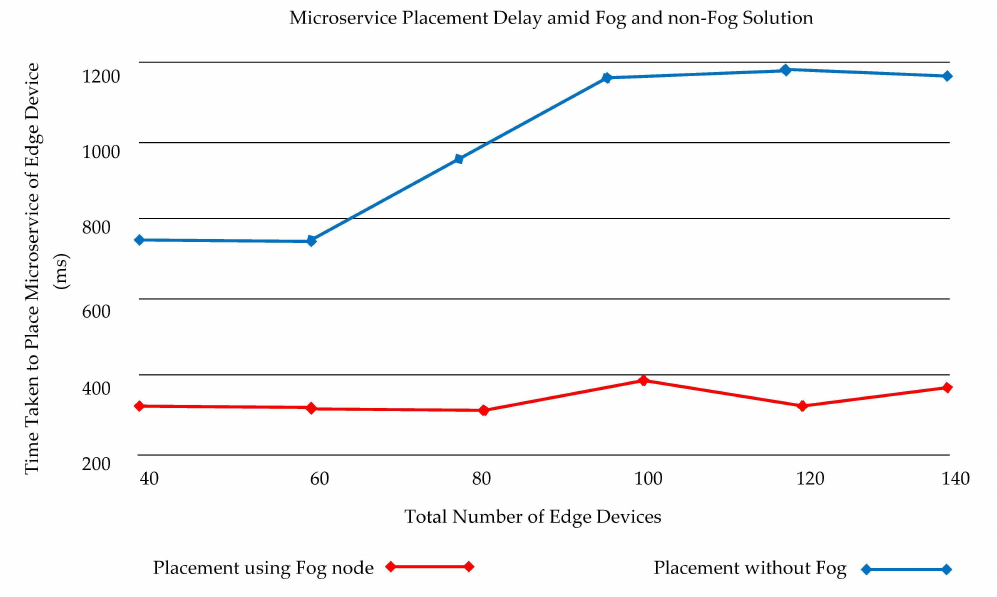
Figure 16. Microservice placement delay in the fog and cloud